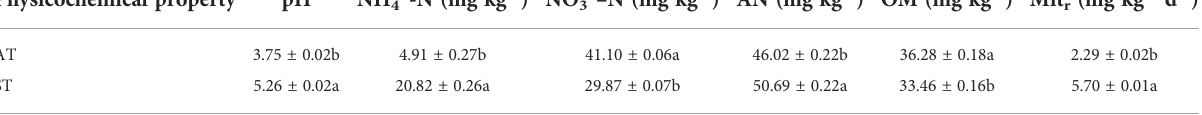
TABLE 1 physiochemical properties of tea soils with different pH values. Physicochemical